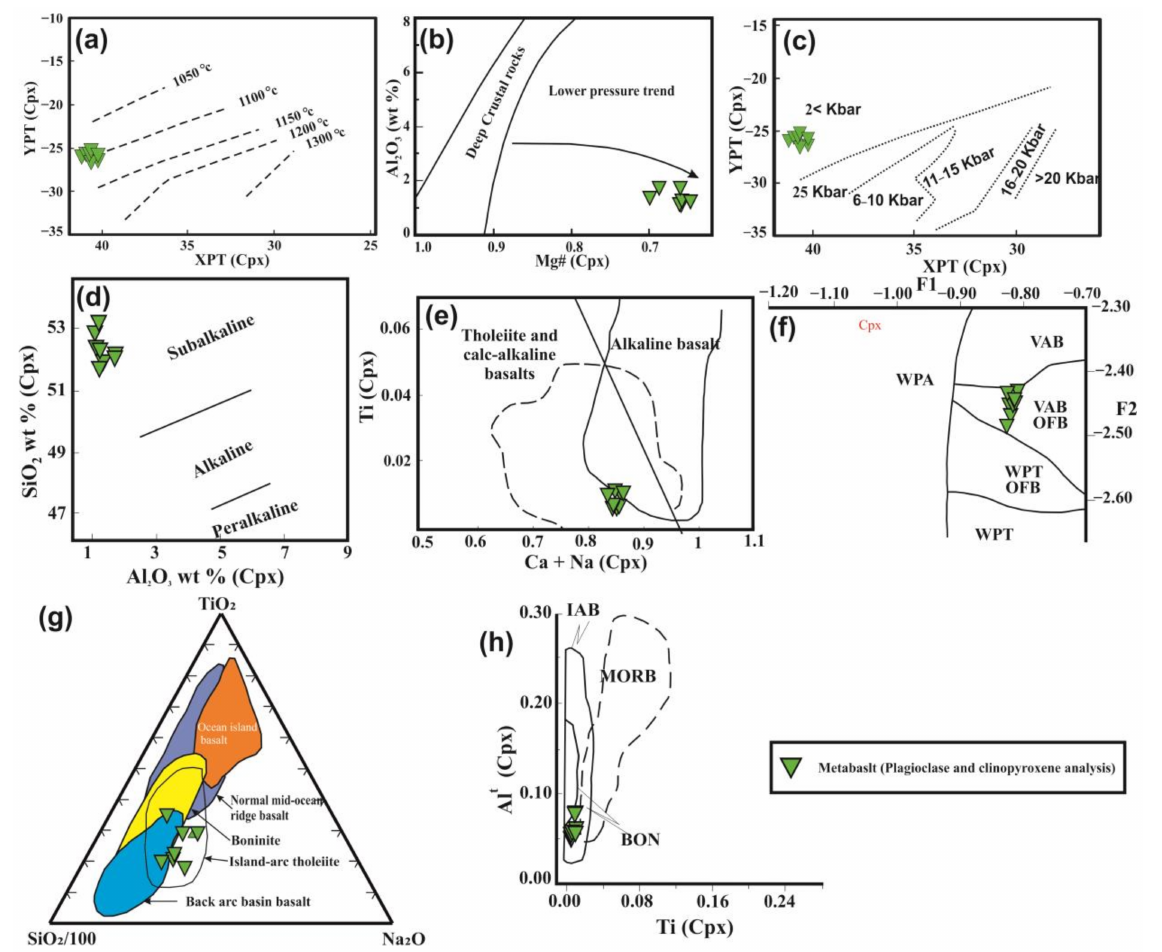
Figure 15. ( a ) YPT versus XPT diagram for the clinopyroxene crystallization temperature [72]. ( b ) Al 2 O 3 (wt%) vs. Mg# diagram for Cpx [75]. ( c ) YPT versus XPT diagram for Cpx crystallization pressure [72]. ( d ) SiO 2 vs. Al 2 O 3 diagram for Cpx [67]. ( e ) Ti vs. Ca + Na diagram for Cpx [76]. ( f ) F1 vs. F2 diagram for Cpx [77]. ( g ) TiO 2 –SiO 2 /100–Na 2 O diagram for Cpx [78]. ( h ) Cations of Al t versus Ti for Cpx